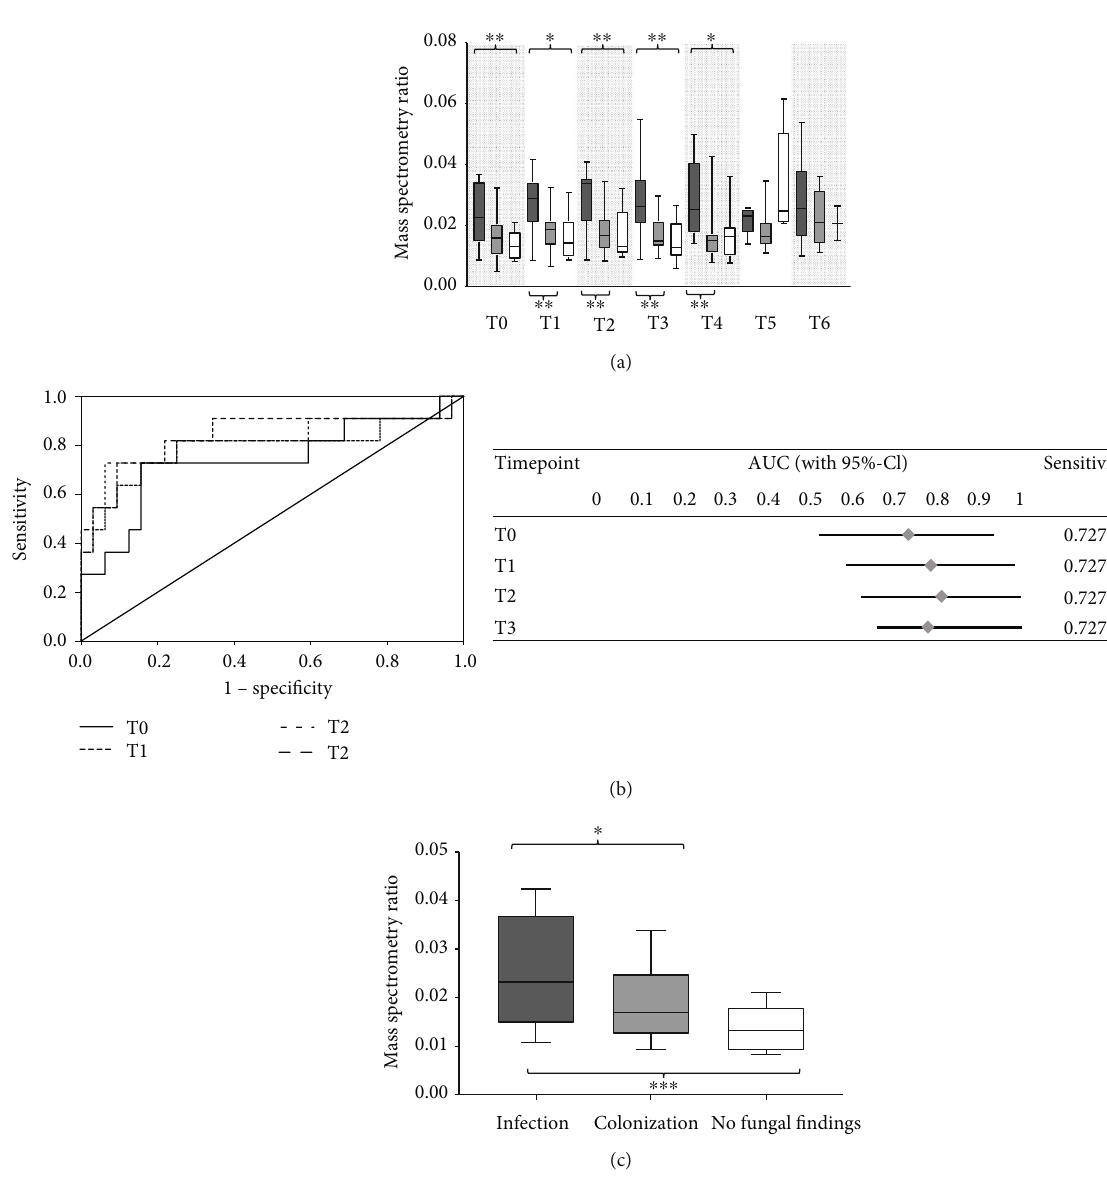
Figure 1: Plasma concentrations of sICAM-1 for the detection of an IFI in patients with septic shock. (a) Plasma concentrations of sICAM-1 were measured by mass spectrometry in patients su ff ering from septic shock with an invasive fungal infection (IFI, dark grey box), a fungal colonization (light grey box), or without any fungal fi ndings (white box). Plasma samples were collected at the onset of septic shock (T0) and 1 day (T1), 2 days (T2), 7 days (T3), 14 days (T4), 21 days (T5), and 28 days (T6) afterwards. Data in box plots are given as median,